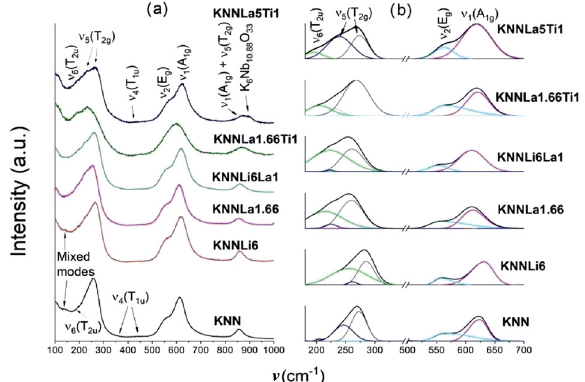
Fig. 3 Raman spectra at room temperature of pure and doped KNN: (a) at the frequency range of 100–1000 cm –1 ; (b) the deconvolution bands centered at approximately 260 cm –1 (  5 and  6 ) and 630 cm –1 (  2 and  1